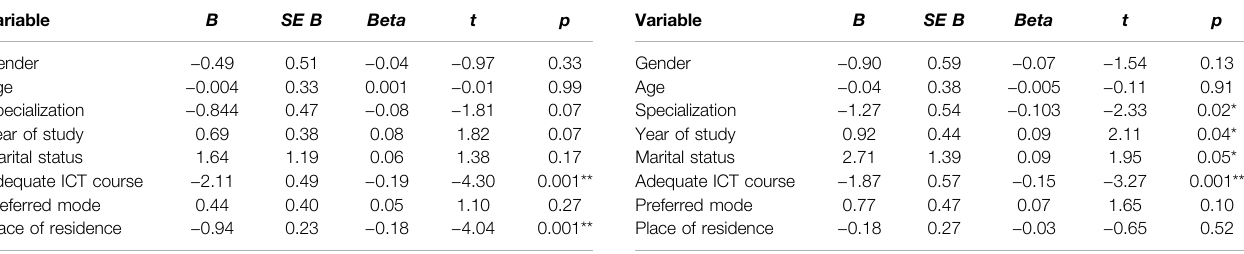
TABLE 7 | Summary of demographic variables predicting academic skills.